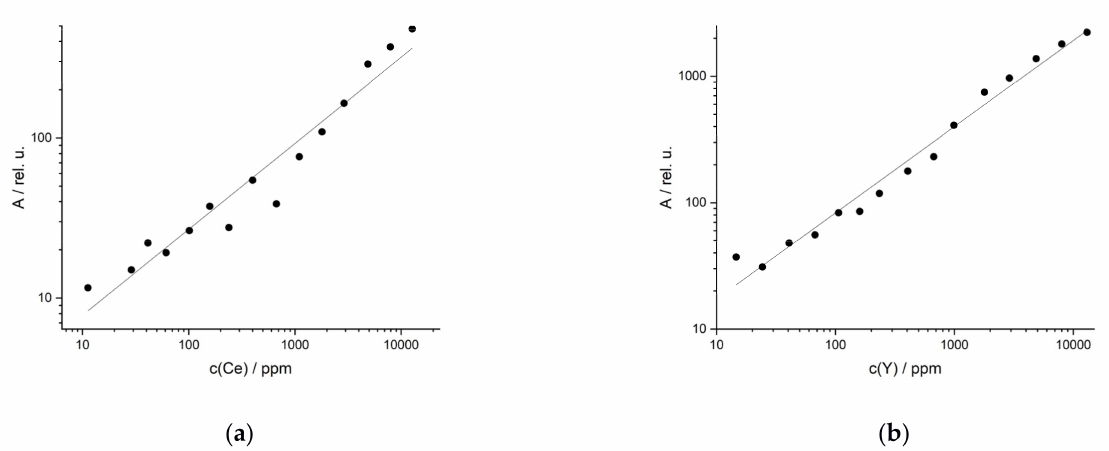
Figure 5. Univariate regression of synthetical samples in soil of ( a ) Ce (R 2 (413.76 nm) = 0.99) and ( b ) Y (R 2 (488.36 nm) = 0.98).